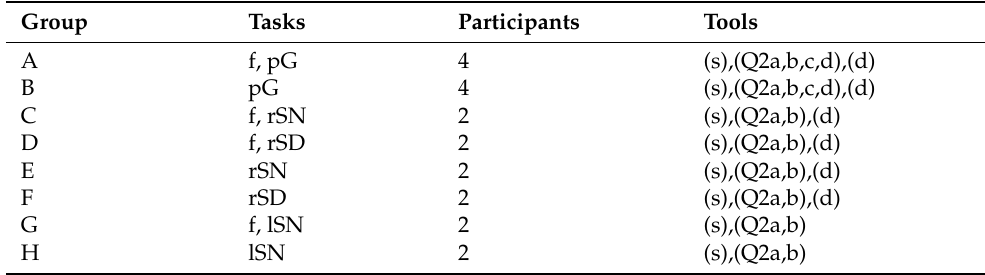
Table 2. Groups, tasks and participants, and evaluation tools used. Group Tasks Participants